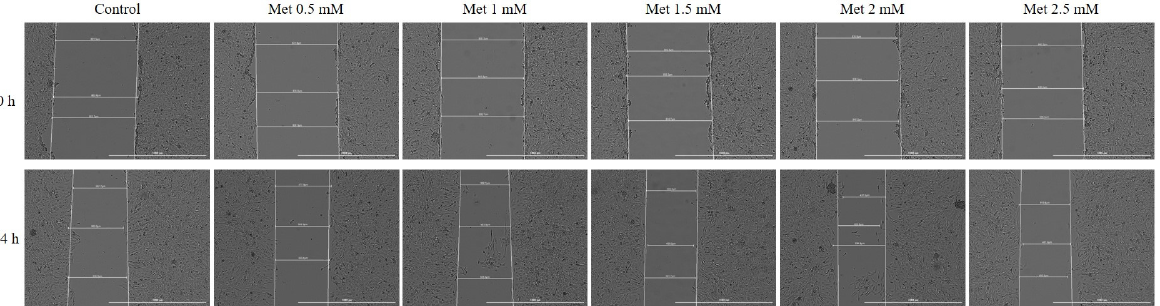
Figure 6. Representative images of the migratory capacity of HepaRG cells following the treatment with Met (0.5, 1, 1.5, 2 and 2.5 mM) for 24 h. Images were captured at 0 h and 24 h after stimulation with Met versus control cells. The scale bars indicate 1000 μ m.